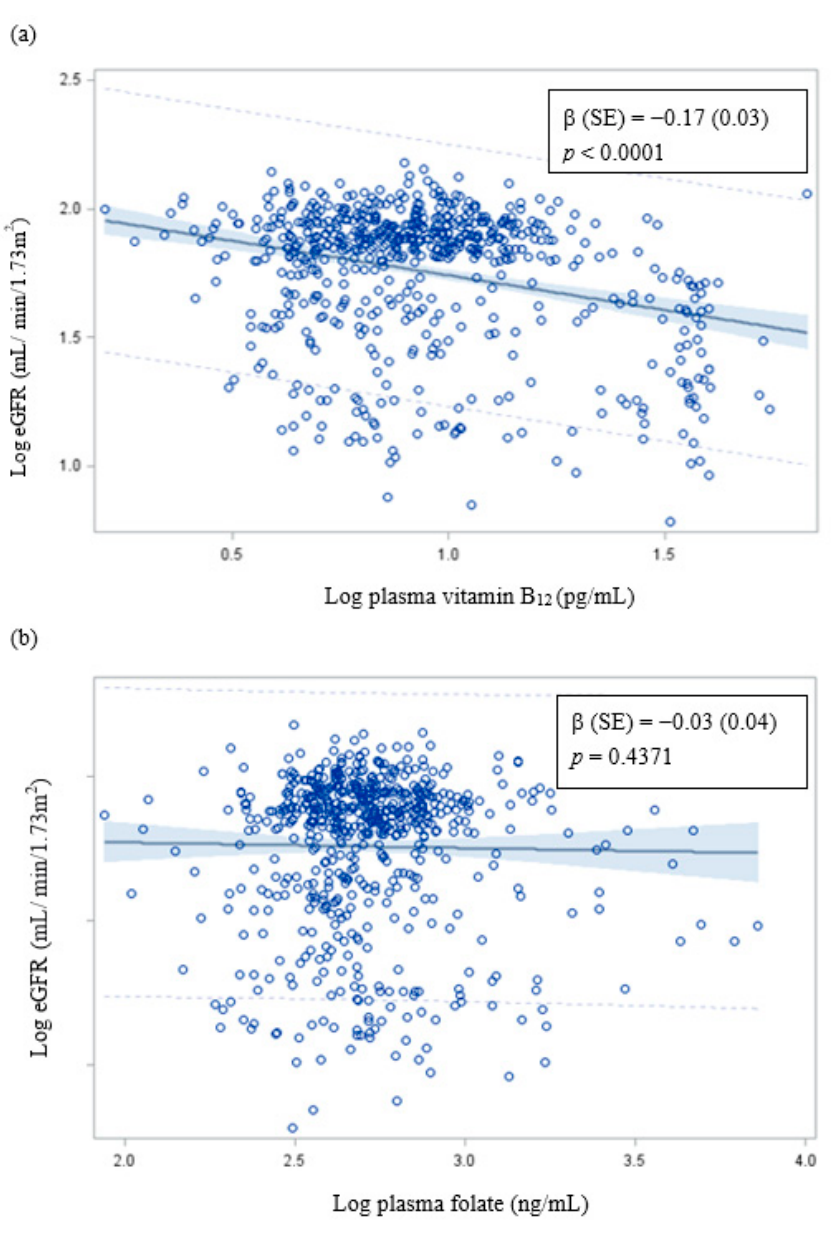
Figure 1. Correlation of eGFR with ( a ) plasma vitamin B 12 and ( b ) plasma folate. β (SE): Adjusted for age; sex; educational level; alcohol, coffee, and tea consumption; analgesic usage; diabetes; hypertension; blood lead and cadmium levels; and total urinary arsenic ( µ g/g creatinine).